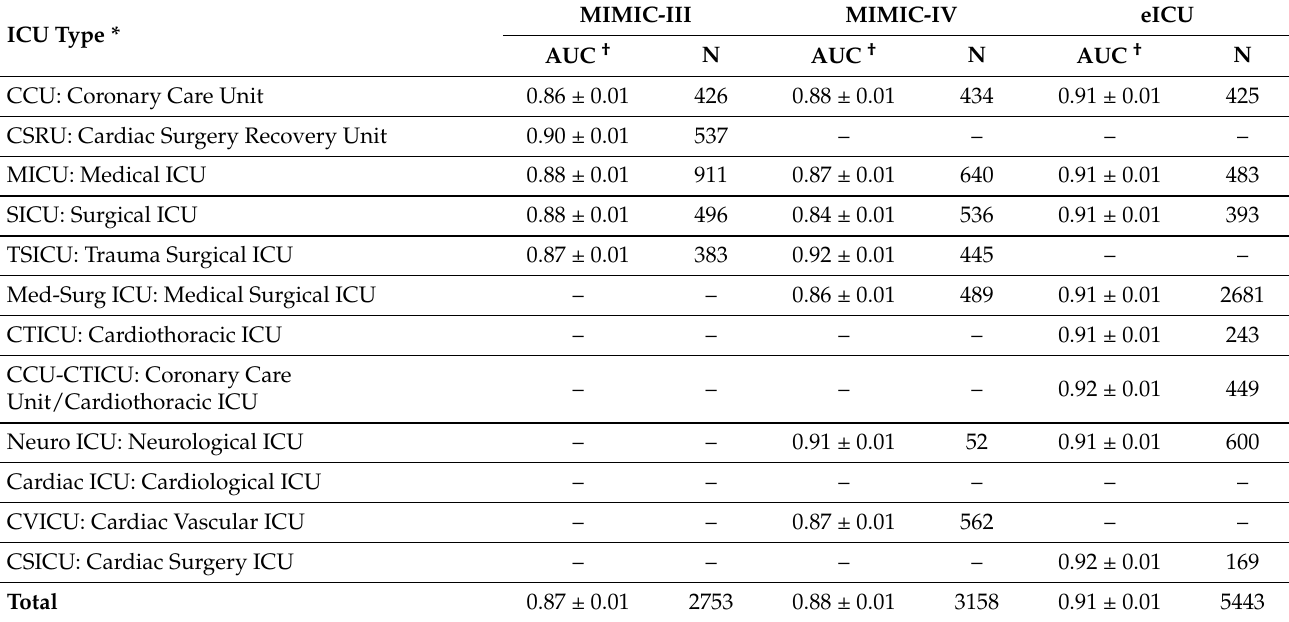
Table 6. Performance of our 48 h GRU model for each intensive care type on the test set for each critical care database. ICU Type